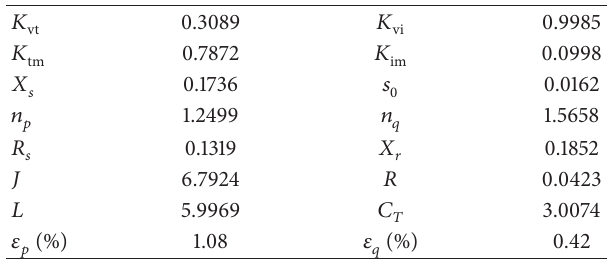
Table 5: Parameter of TPSLM.